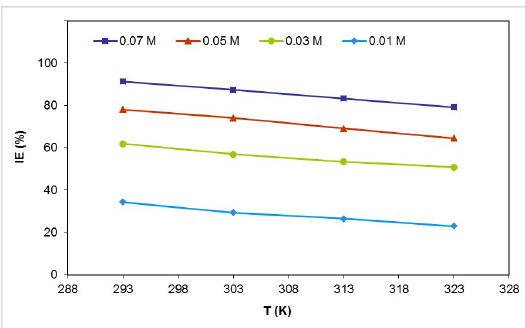
Figure 4. Effect of temperature on inhibition efficiency of TTA with different concentrations (0.01 to 0.07 M) on mild steel in HCl solution at various temperatures (293, 303, 313 and 323